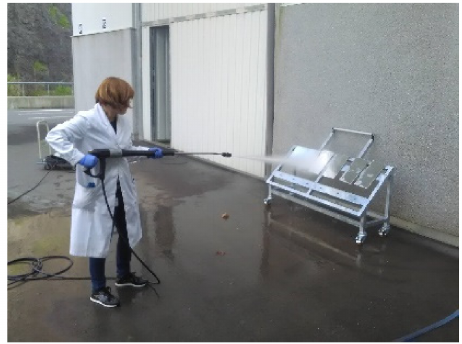
Figure 7. High pressure water jet cleaning at 1.5 m